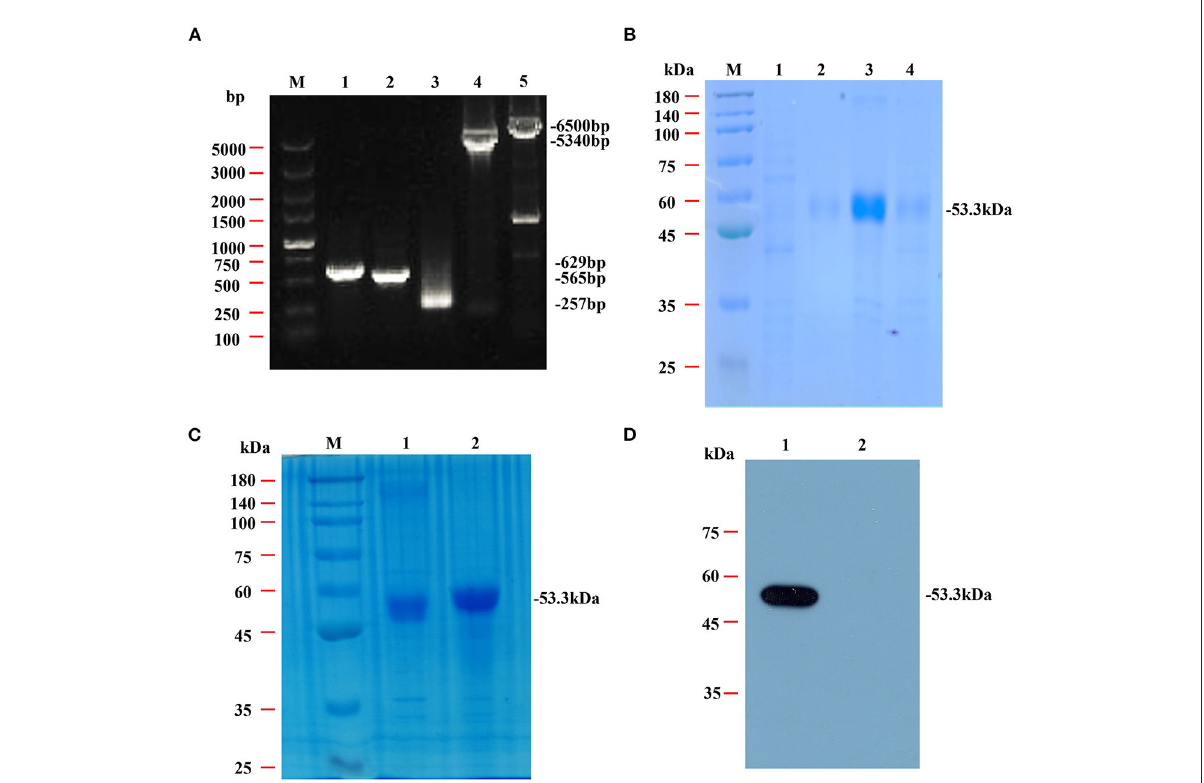
FIGURE2 Amplification, SDS-PAGE and western blotting analysis of the chimeric protein rSRS2-SAG1-GRA7. (A) PCR amplification of the NcSRS2, NcSAG1, NcGRA7 genes and plasmid backbone fragment. Lane M, DL5000 DNA marker. Lane 1, the NcSRS2 gene fragment. Lane 2, the NcSAG1 gene fragment. Lane 3, the NcGRA7 gene fragment. Lane 4, the pET-28a plasmid backbone fragment. Lane 5, the 28a-S2-G1 carrier skeleton fragment. (B) SDS-PAGE analysis of chimeric protein rSRS2-SAG1-GRA7. Lane M, prestained protein molecular weight standard. Lane 1, uninduced E. coli cell lysate. Lane 2, the supernatant of induced E. coli cell lysate. Lane 3, the precipitate of induced E. coli cell lysate. Lane 4, induced E. coli cell lysate. (C) SDS-PAGE analysis of chimeric protein rSRS2-SAG1-GRA7. Lane M, prestained protein molecular weight standard. Lane 1, induced E. coli cell lysate. Lane 2, purified chimeric protein rSRS2-SAG1-GRA7 by affinity chromatography of Ni-NTA spin column. (D) Western blotting analysis of chimeric protein rSRS2-SAG1-GRA7. Lane 1, Chimeric protein rSRS2-SAG1-GRA7 and mouse serum positive for neosporosis. Lane 2, Chimeric protein rSRS2-SAG1-GRA7 and mouse serum positive for